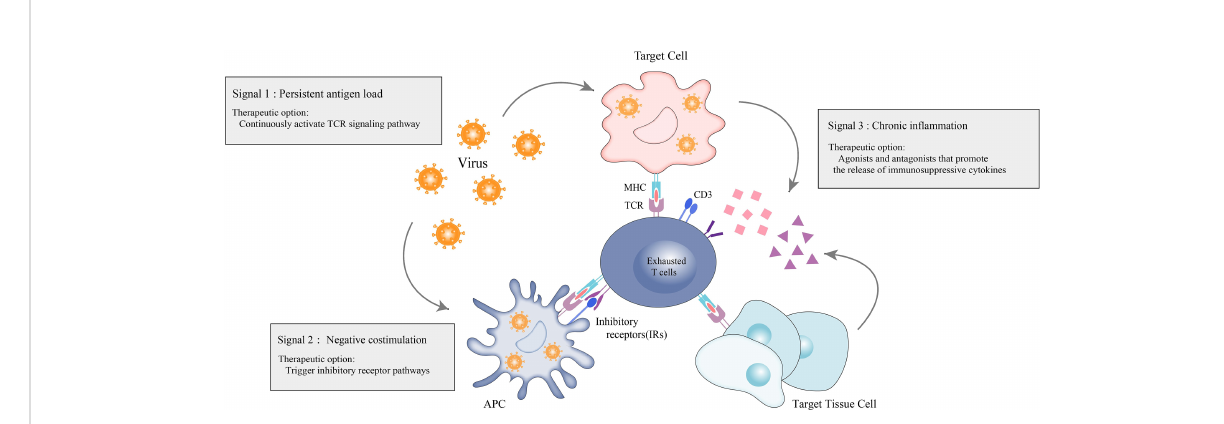
FIGURE 3 Therapeutic options for exhausted T-cells in autoimmunity. Therapeutic options for autoimmune diseases based on the hypothesis that promoting T-cell exhaustion can be therapeutic. Persistent antigen load from virus or tumor (signal 1) drives hyperactivation of T-cells and ultimately leads to sustained coexpression of multiple inhibitory receptors on T-cells and their ligands on antigen presenting cells (APCs), virally- infected cells and target tissue cells. The inhibitory receptors prompt negative costimulation (signal 2) to T-cells. In response to persistent antigen load, virally-infected cells, APCs and target tissue cells further drive exhaustion by producing proin fl ammatory cytokines and immunosuppressive cytokines to promote the exhaustion state of